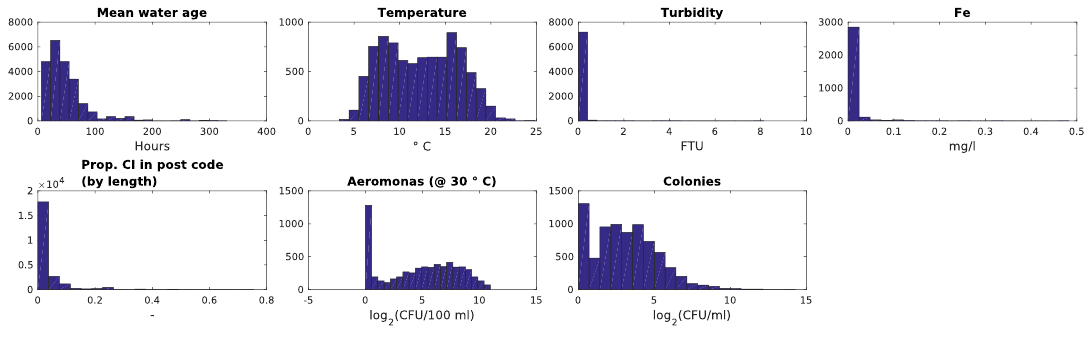
Figure 1. Data distribution of Dutch dataset. Table 3. Dutch dataset, after adding water age and percentage with Cast Iron pipes for PWN